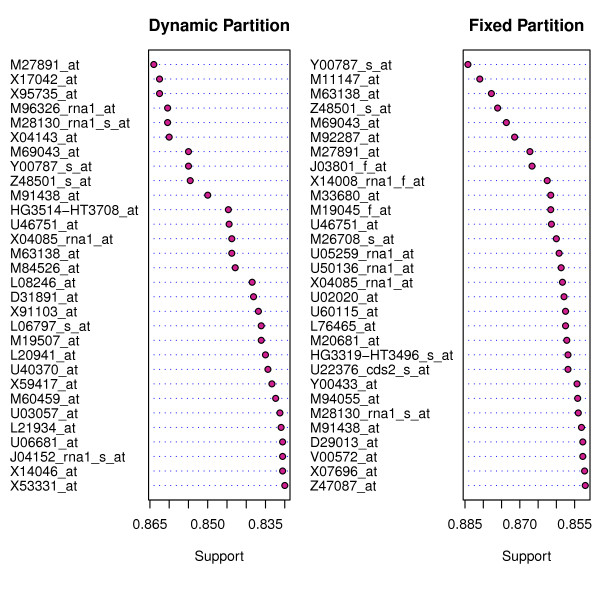
Supports for the first 30 most relevant genes using the Golub leukemia data (Left panel: using dynamic partition; Right panel using fixed partition of the data for testing and training).